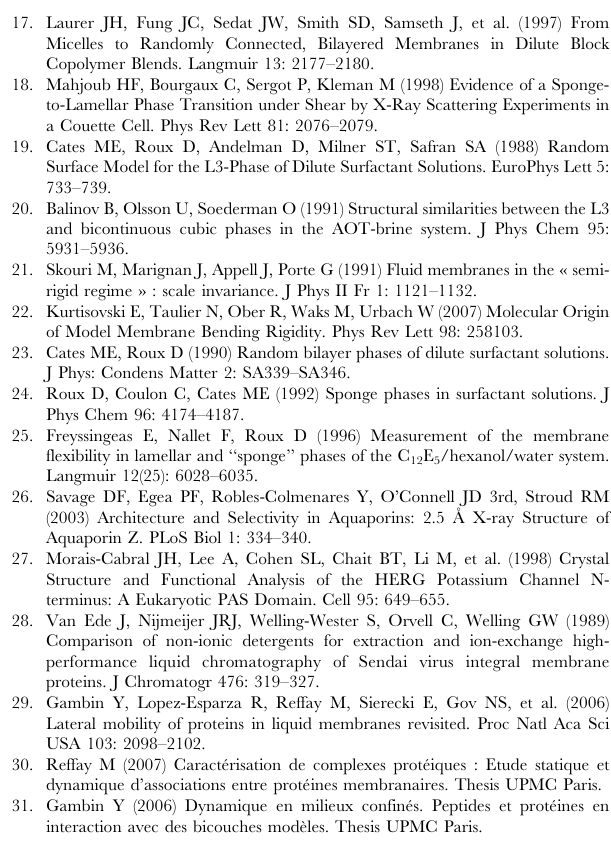
Figure S1 X-ray spectra of the L3 phase with and without proteins. X-ray spectra realized for a L3 phase of Q m = 0.3 with (- -) and without (-) MexA protein. The insert shows a graph of the